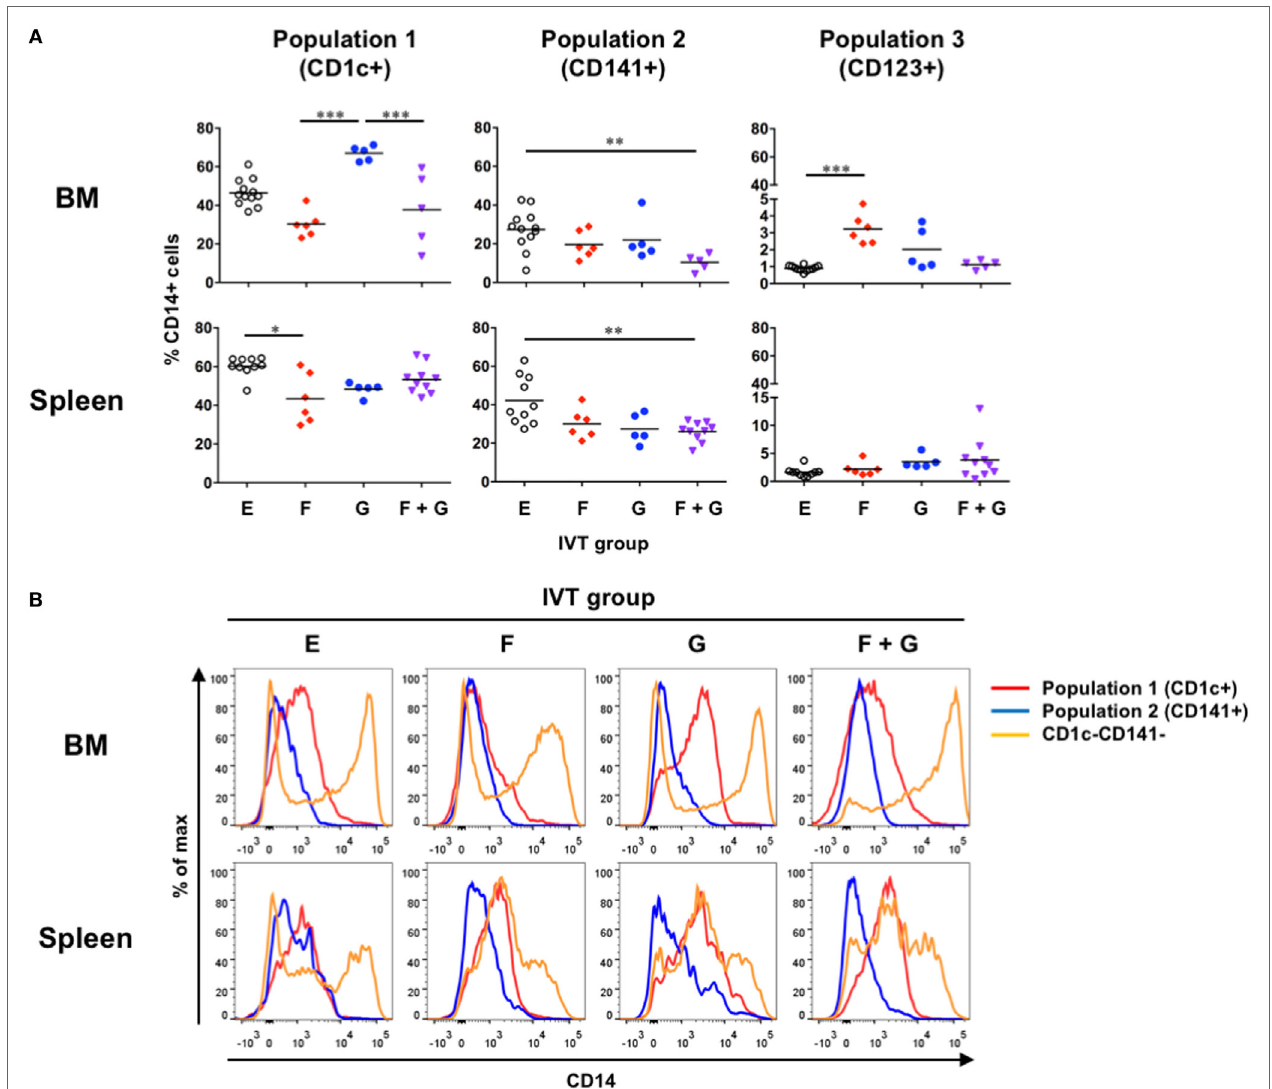
FigUre 3 | Development of CD14 + monocyte-like cells in hNOJ mice. Cells were prepared from the bone marrow and spleen of hNOJ mice within each in vivo transfection (IVT) group. (a) The percentages of CD14 + cells within CD1c + population (Population 1), CD141 + population (Population 2), and CD123 + population (Population 3) were compared across the IVT groups ( n = 5–12 per group). Significant differences (* P < 0.05, ** P < 0.01, *** P < 0.001) were determined by the Kruskal–Wallis test followed by the Dunn’s multiple comparisons test. (b) Representative histograms of CD14 expression among Population 1, Population 2, and CD1c − CD141 − myeloid